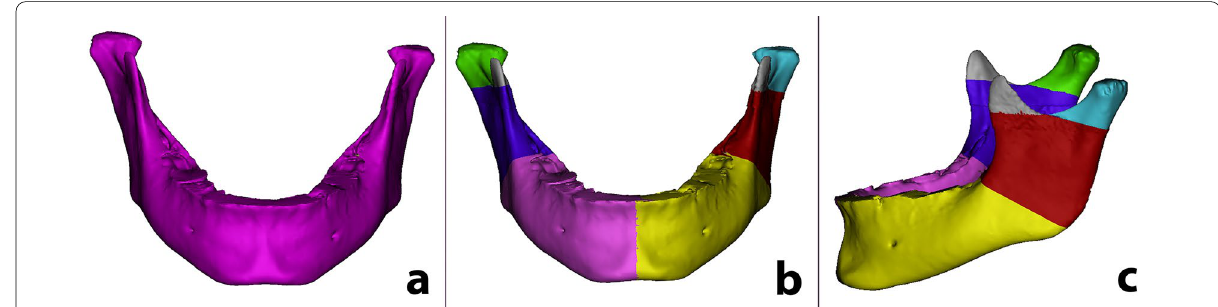
Fig. 5 Example of the steps taken to reconstruct the volumes that have been considered in this study in a patient affected by unilateral TMJ involvement. A The whole mandibular volume has the clinical crowns removed from each tooth. It is performed after the whole mandible has been isolated to remove all biases connected to clinical crown sizes. B The mandibular volume is split into two hemi-mandibular volumes. C In each hemimandible, the following volumes have been completed: corpus, ramus and